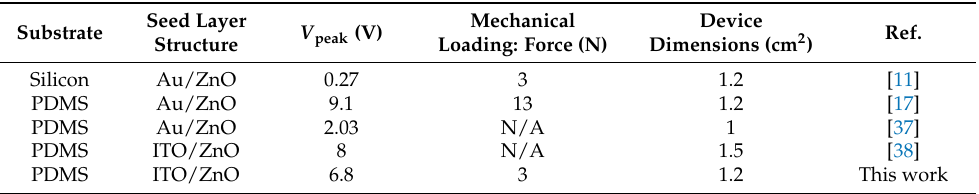
Table 4. Comparison of the characteristics of ZnO NWs-based PENG devices fabricated on different substrates and seed